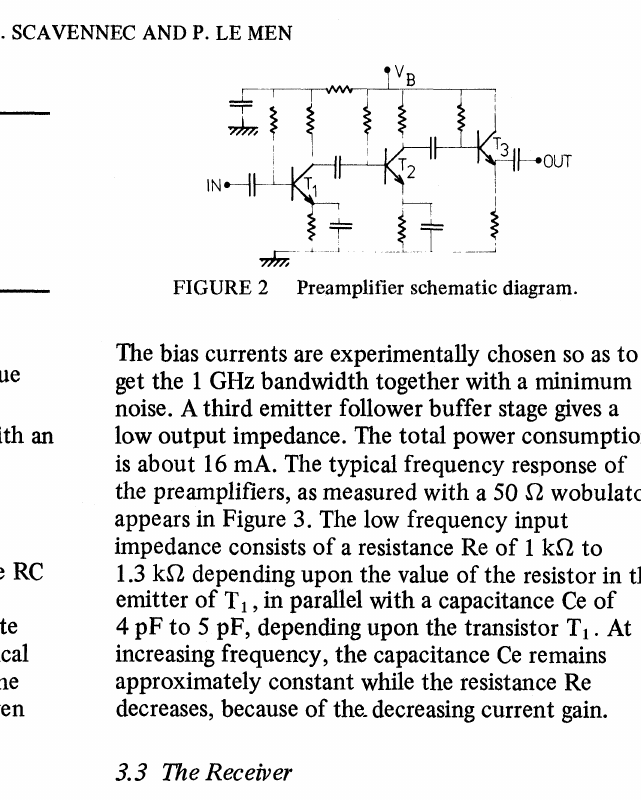
Preamplifier schematic